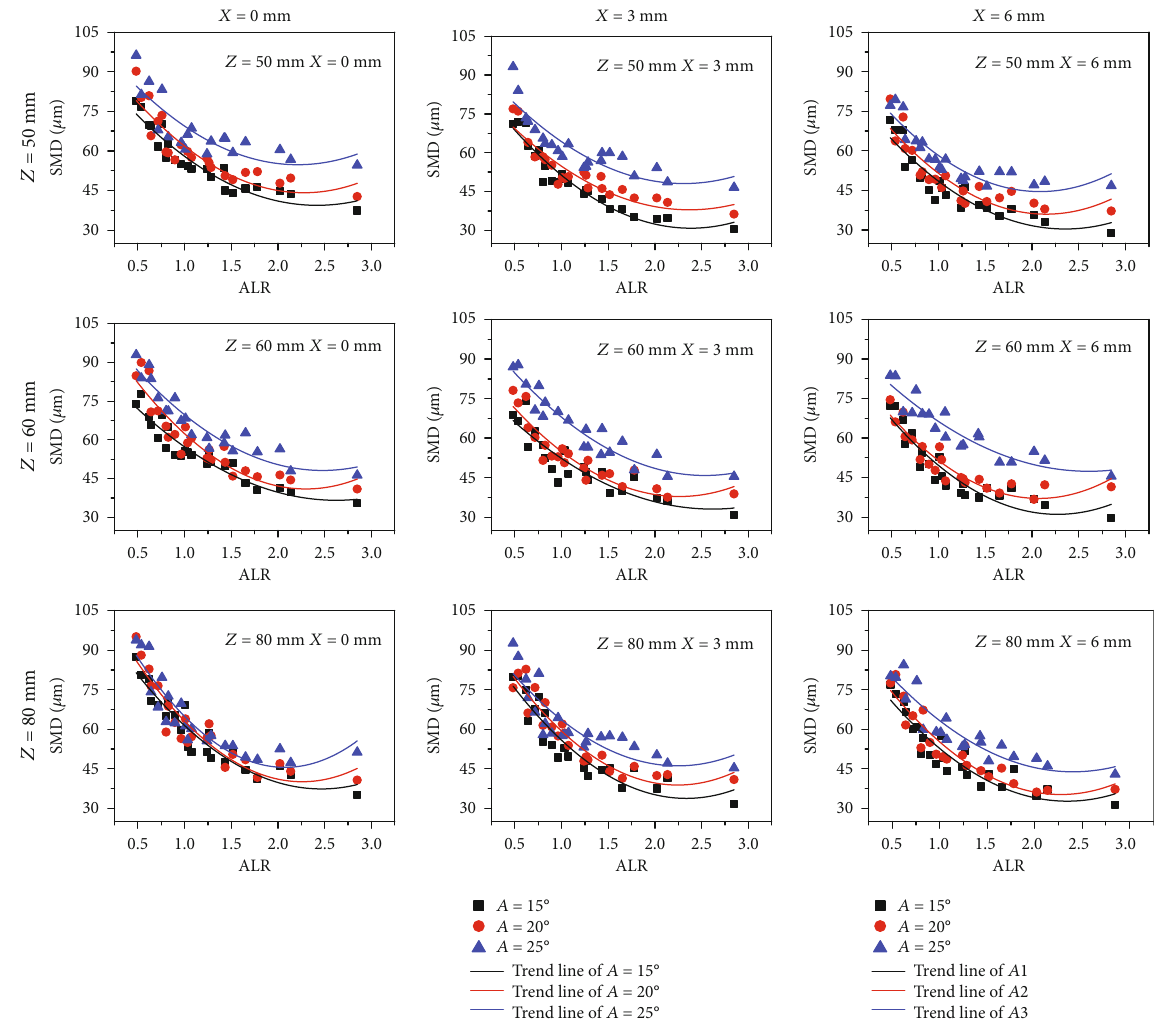
Figure 10: Comparison of SMD characteristics of A series nozzle at various downstream axial distances.